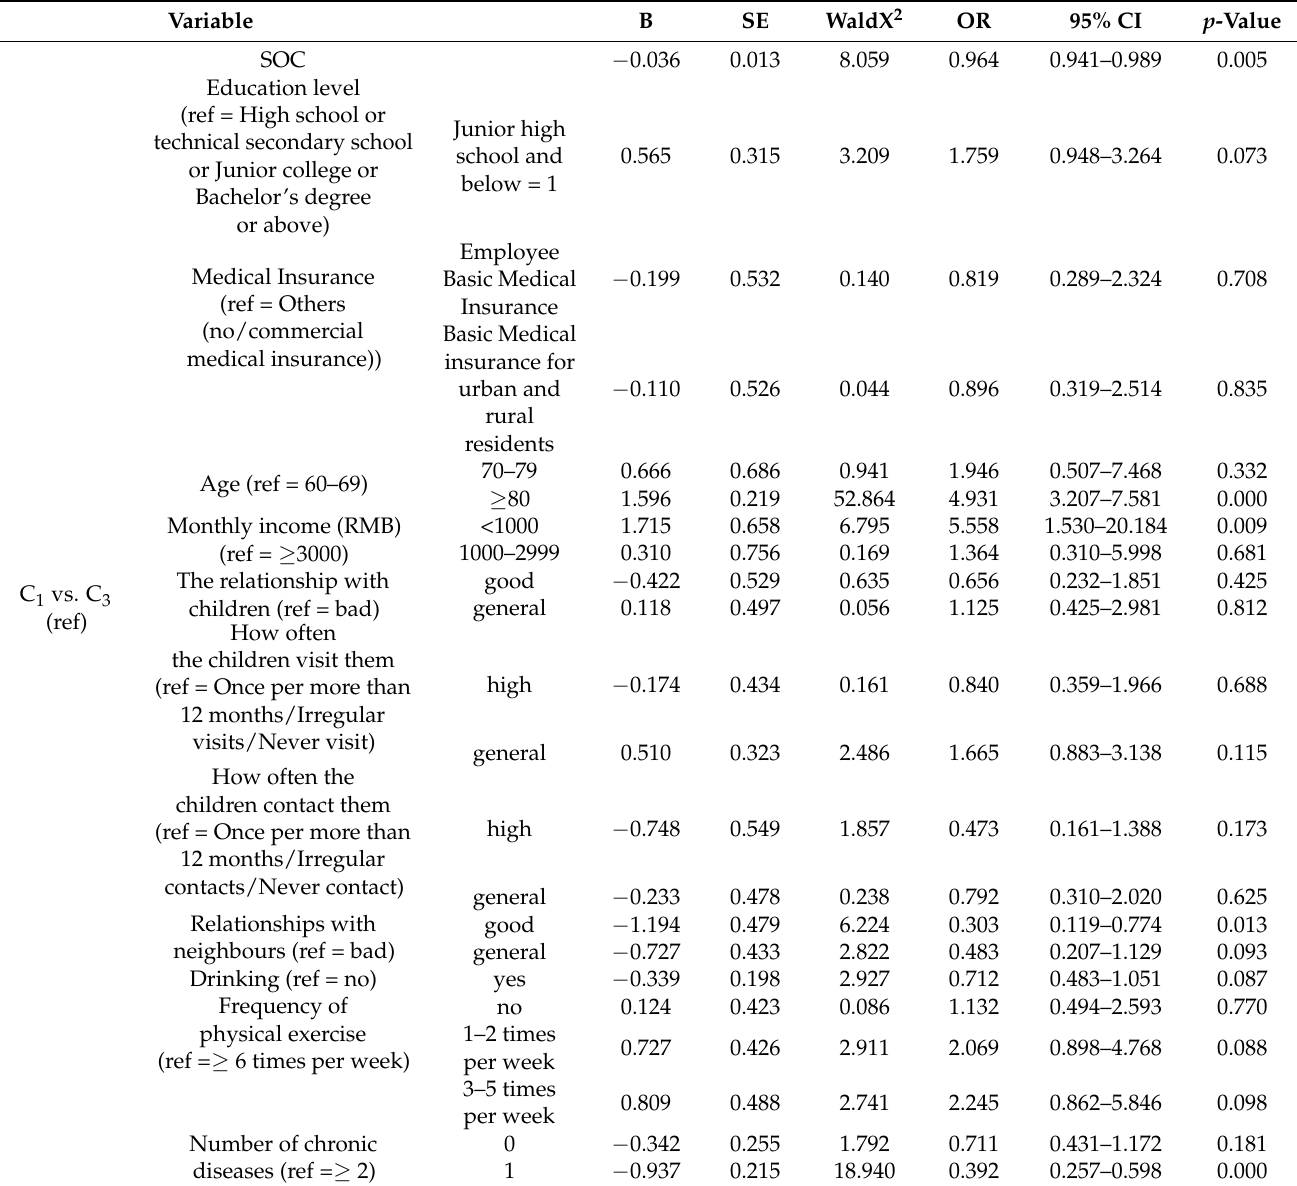
Table 10. Multinomial logistic regression of latent classes on